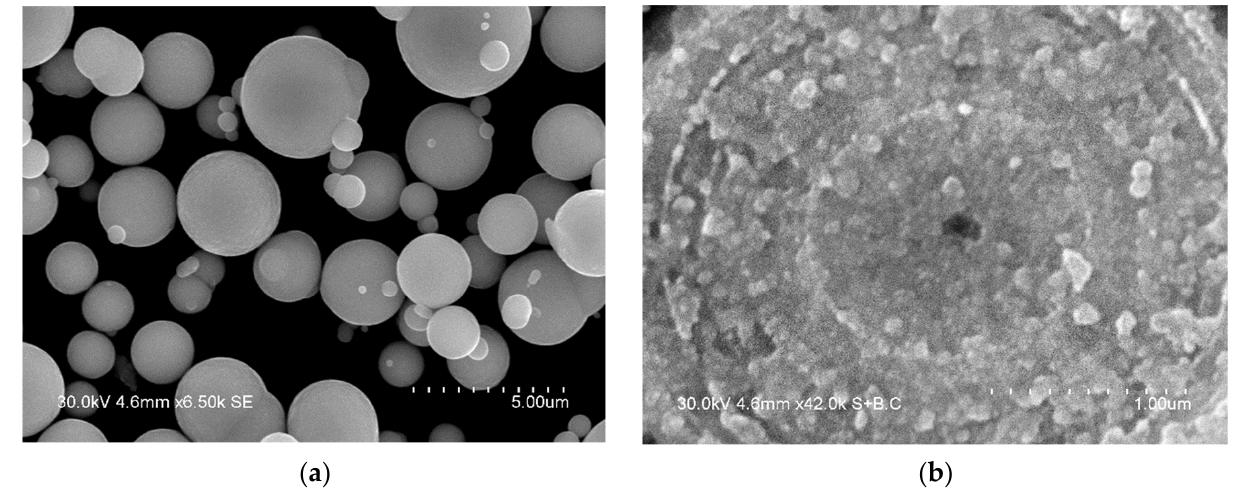
Figure 1. Morphology ( a ) and internal structure ( b ) of the carbonyl iron particles.